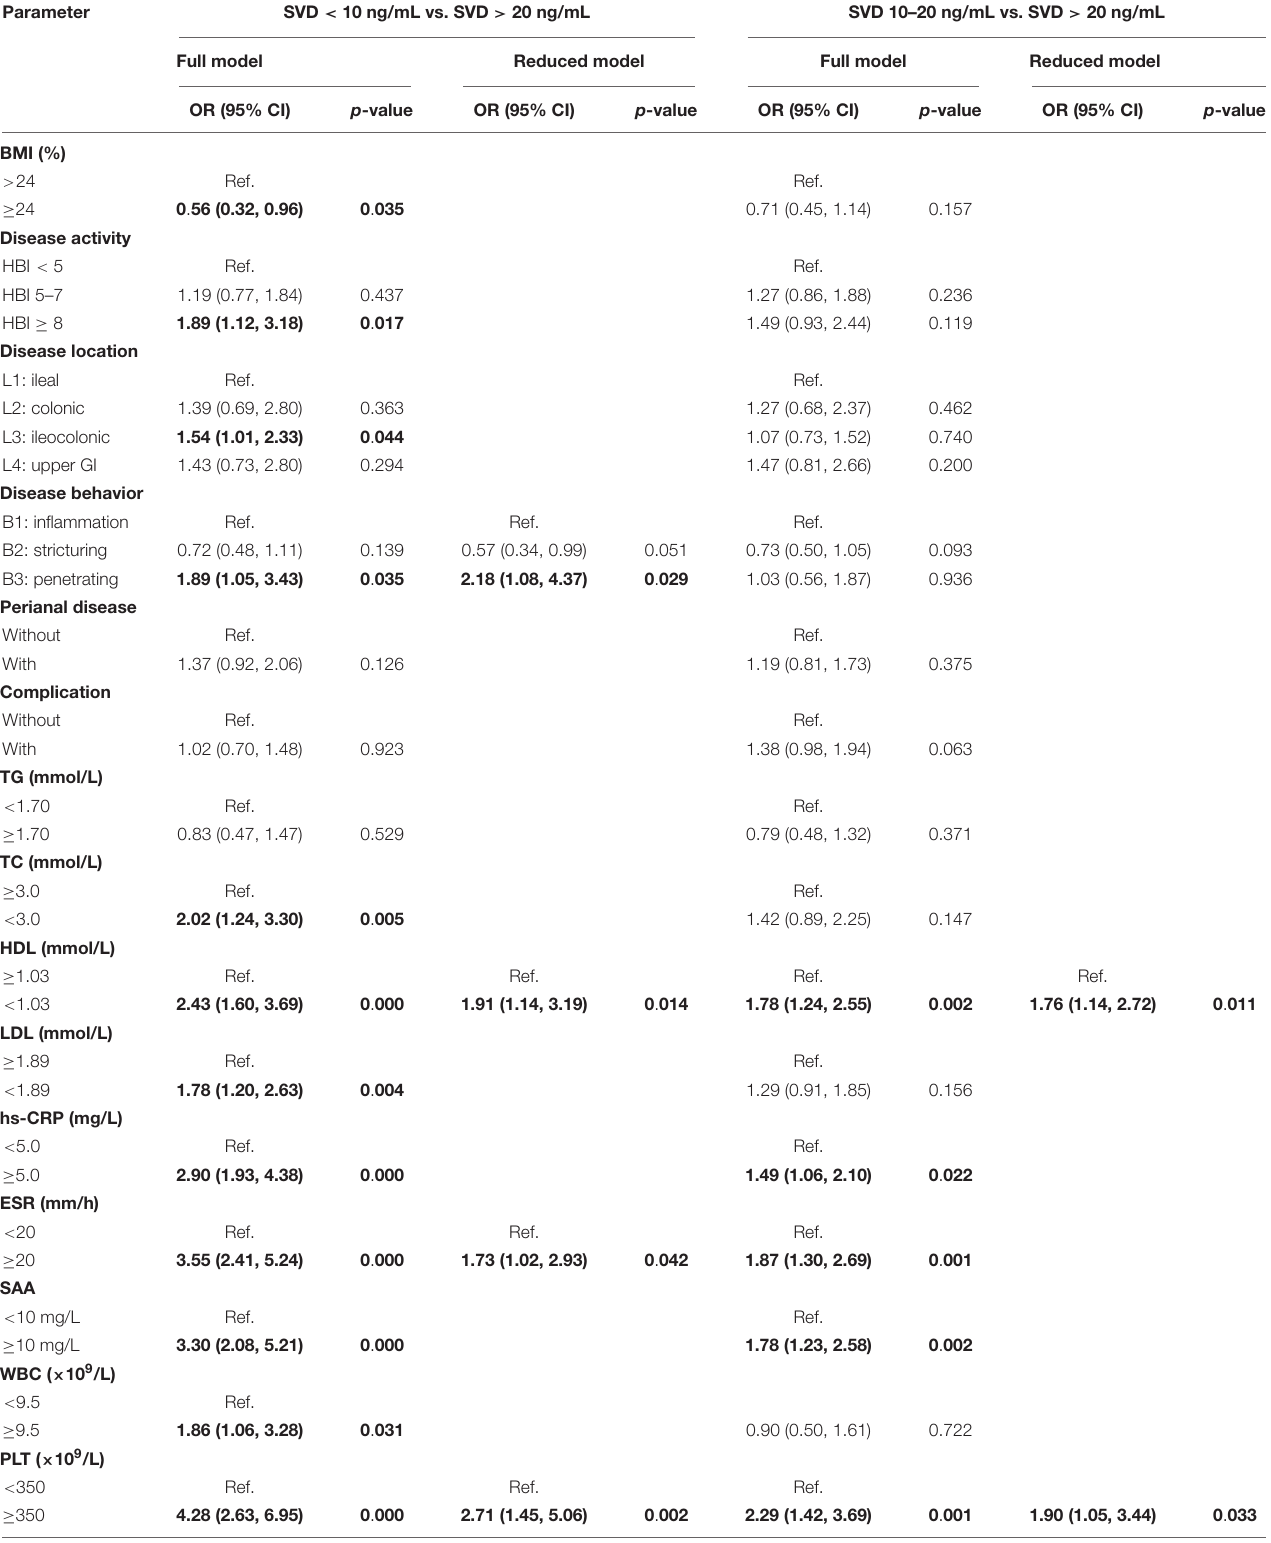
TABLE 5 | Logistic